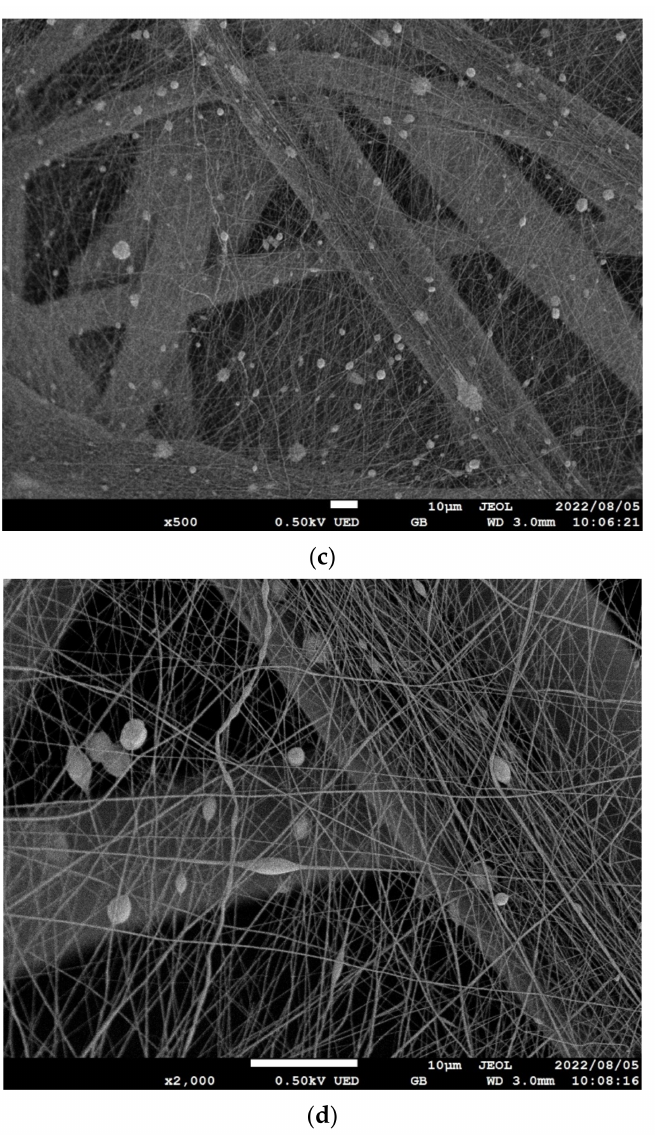
Figure 1. Schematics and micrographs of samples: ( a ) Samples A, B; ( b ) Samples C, D, E, F;